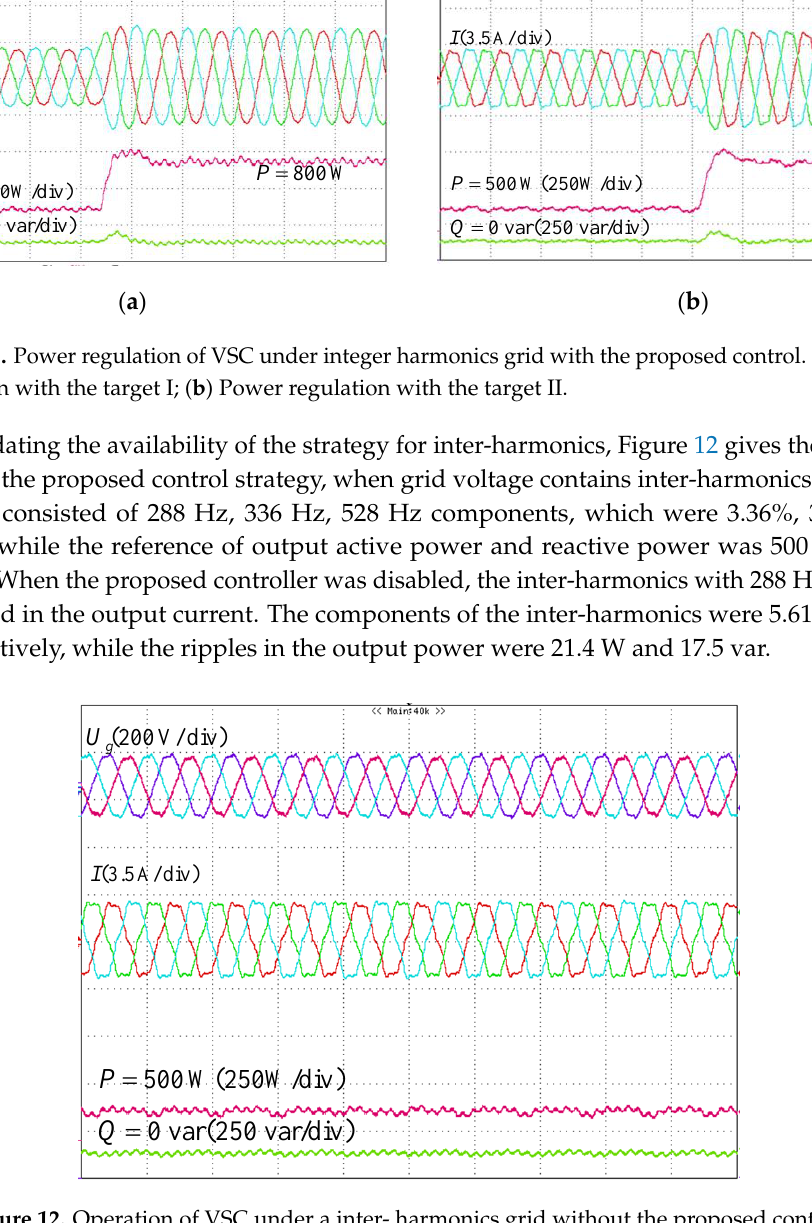
( b ) Figure 13. Operation of VSC under inter-harmonics grid with the proposed control. ( a ) Target I sinusoidal current; ( b ) Target II, steady power without ripples. For investigating the influence on the power tracking caused by the proposed strategy. Figure 14 shows the power regulation of VSC under an integer harmonics grid after enabling the proposed strategy. When the power reference changed from 500 W to 800 W, the output power of VSC could be regulated precisely on the condition of the inter-harmonics grid, the power regulation of VSC system operated well, regardless the control target that was selected as sinusoidal current or smooth power.